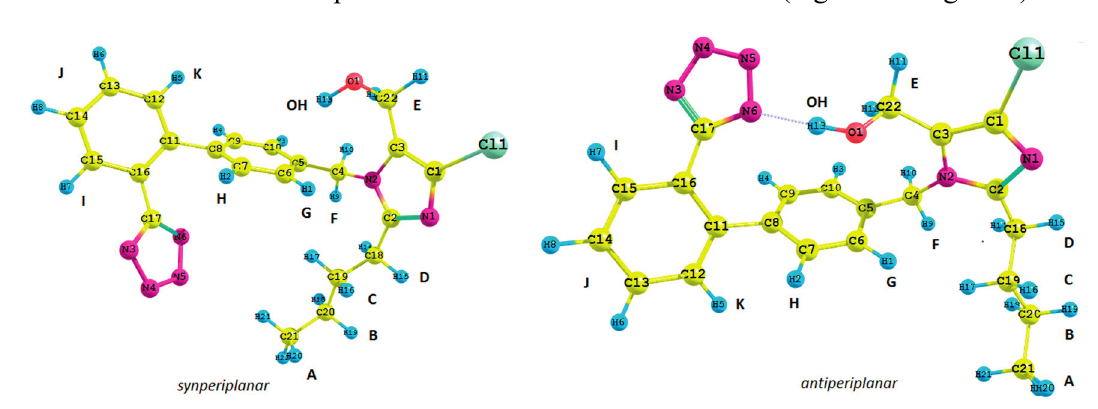
Figure 1. Structure of possible isomers of the losartan anion ( 1 ): antiperiplanar conformation ( anti ) and synperiplanar conformation ( syn